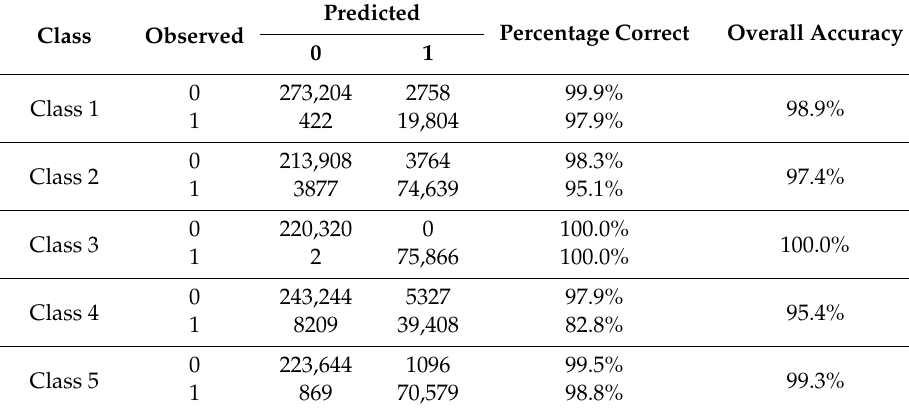
Table 4. Classification table using dataset A (19 July 2019 interval).